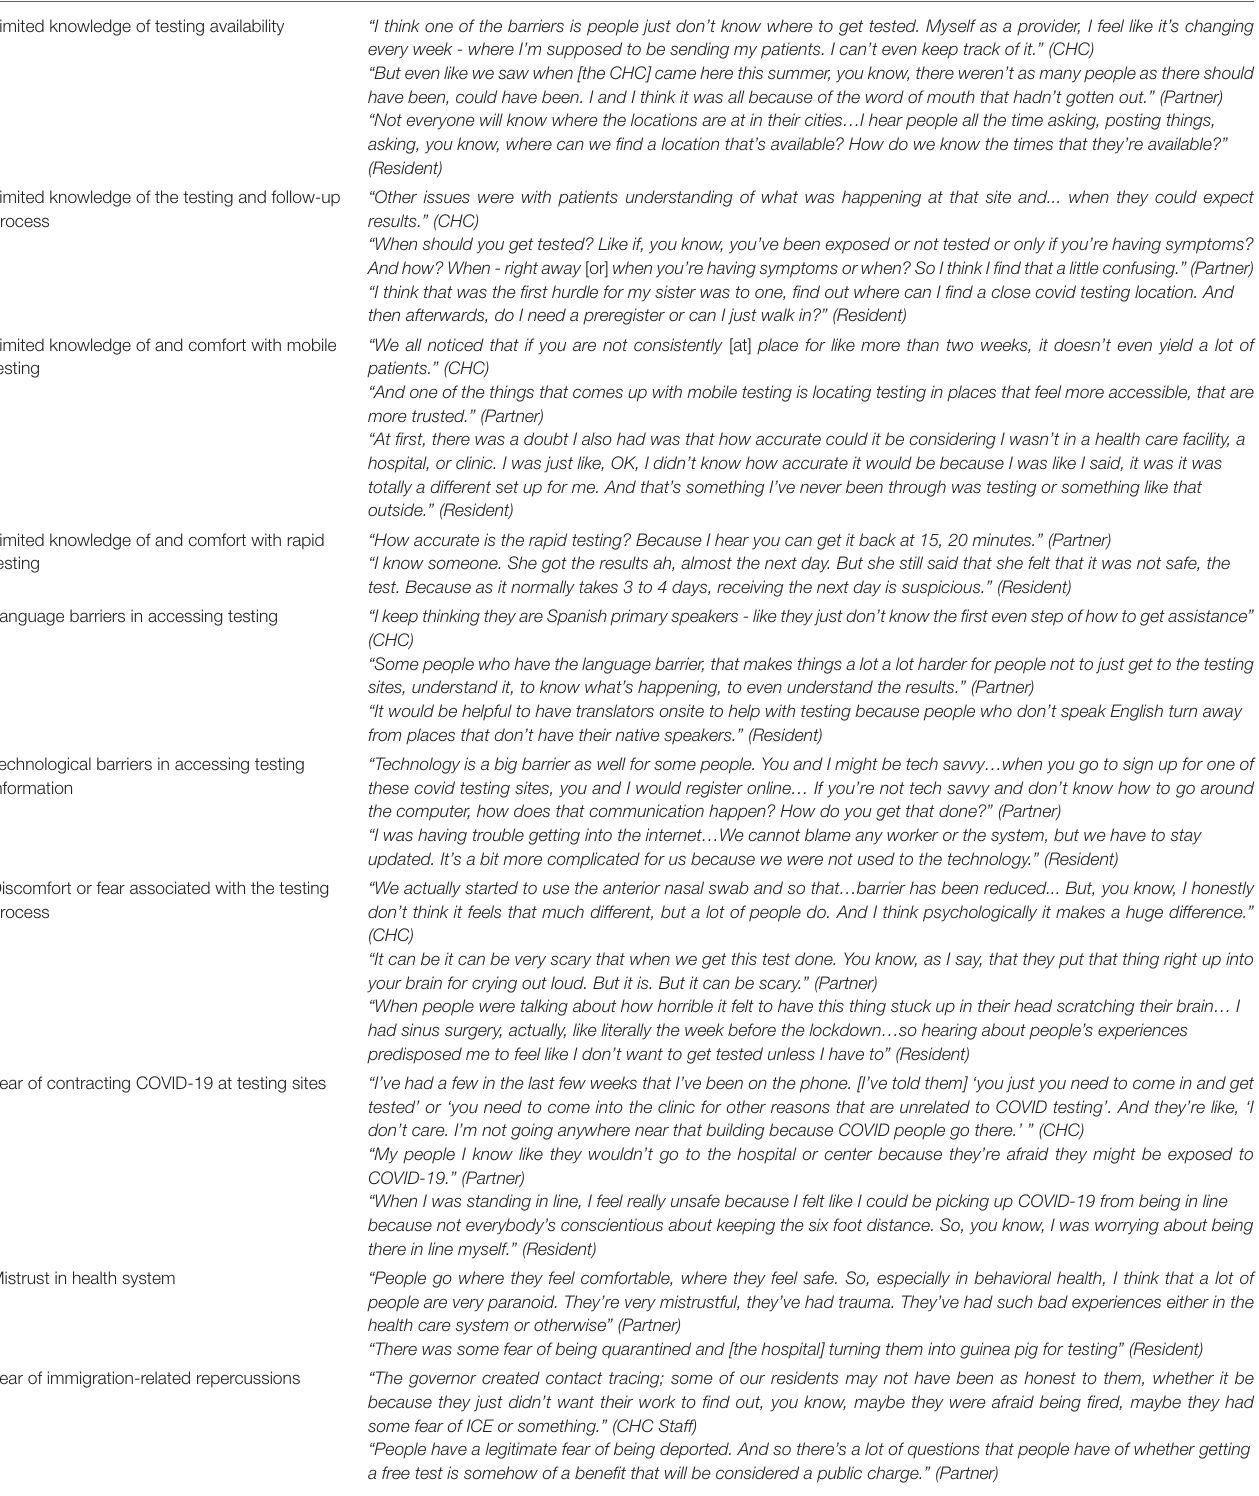
TABLE 5 | Individual factors influencing COVID-19 testing reported by community health center staff, partners, and residents. Theme